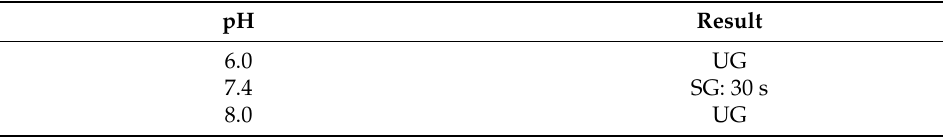
Table 2. Gelation of OE peptides at different